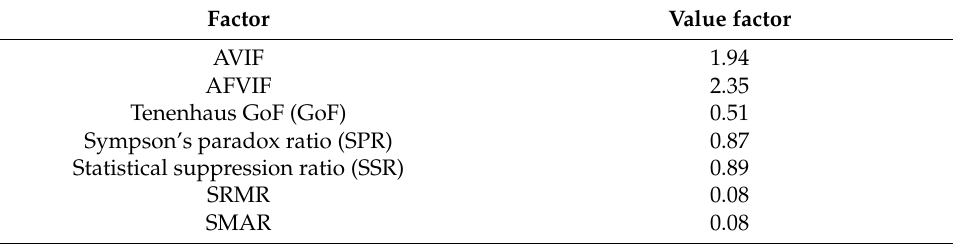
Table 2. Model fit statistics. Factor Value